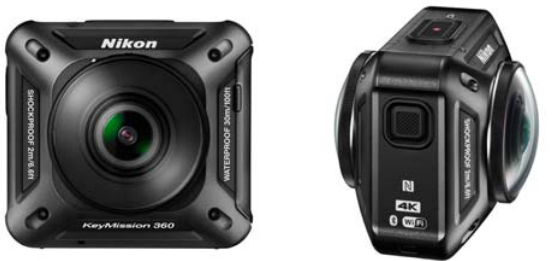
Figure 1. The Nikon Key Mission 360 spherical